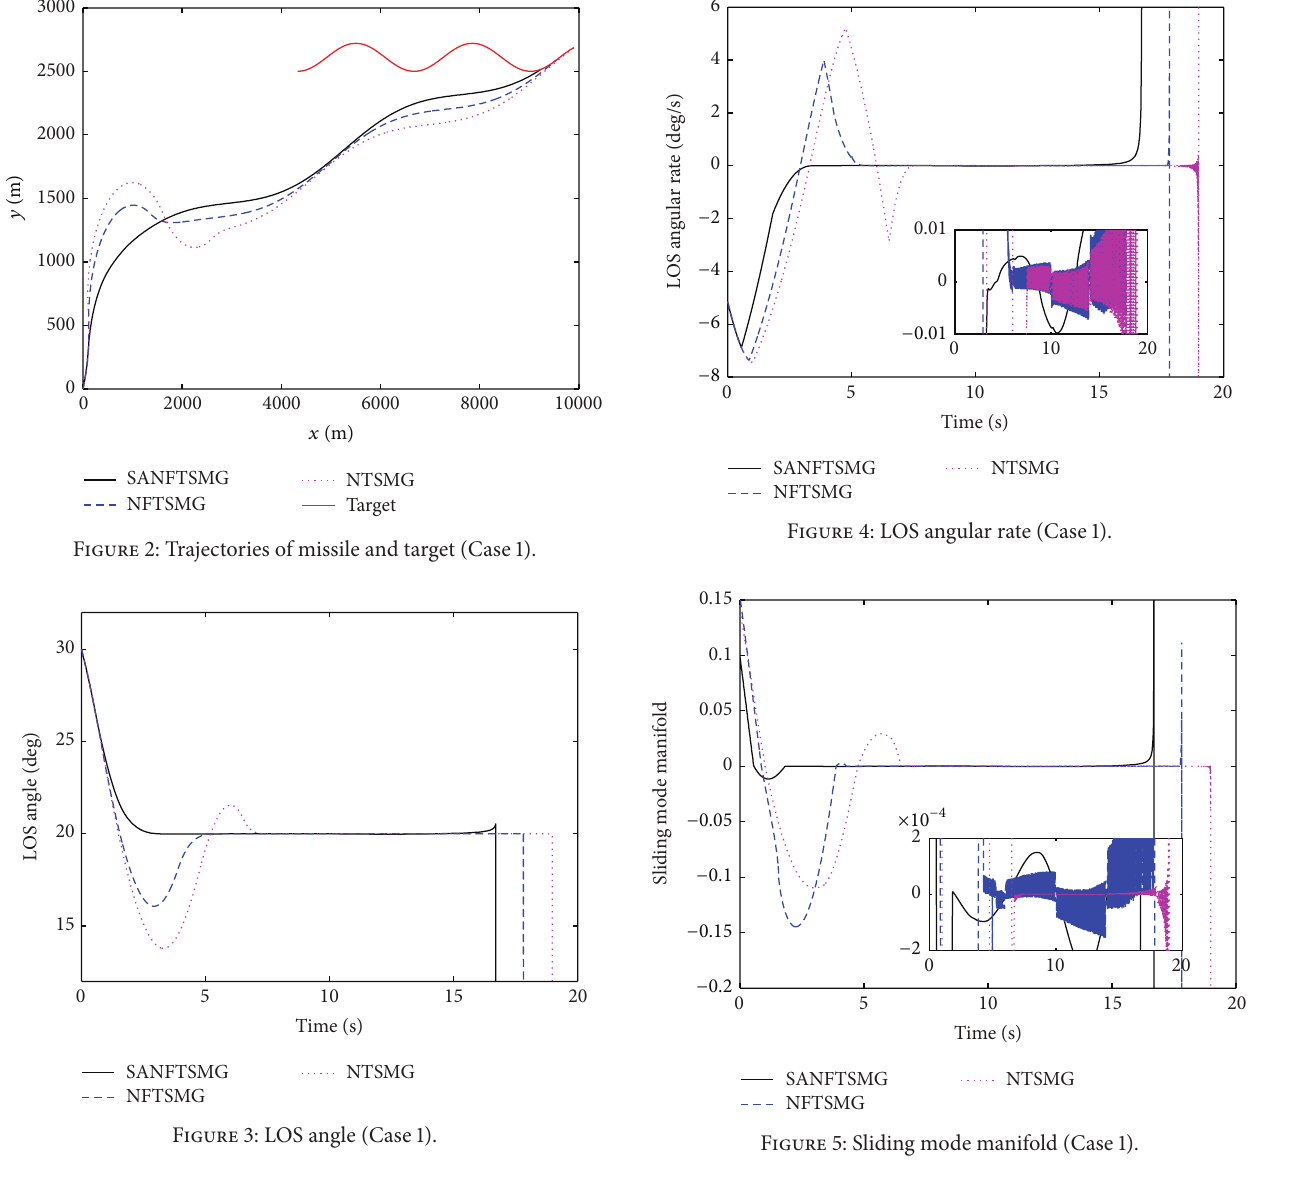
Figure 5: Sliding mode manifold (Case